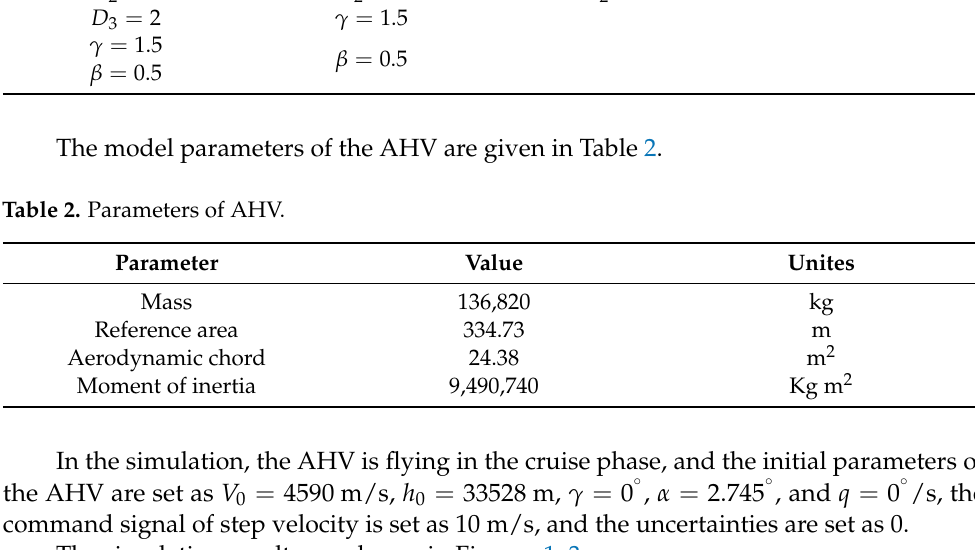
Figure 2. Condition of s1 under reaching laws.